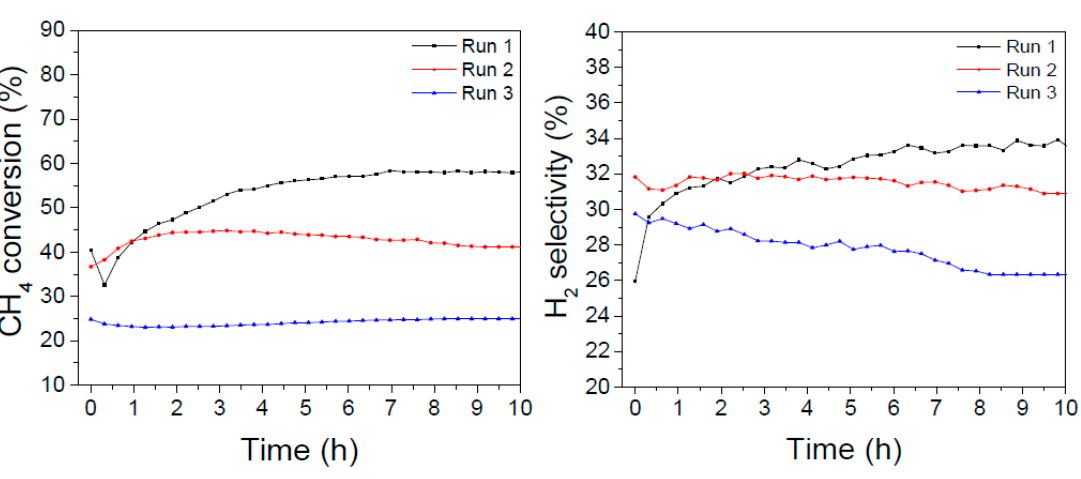
Figure 7. CH 4 conversion and H 2 selectivity as function of time of LaNiO 3 under successive catalytic runs.